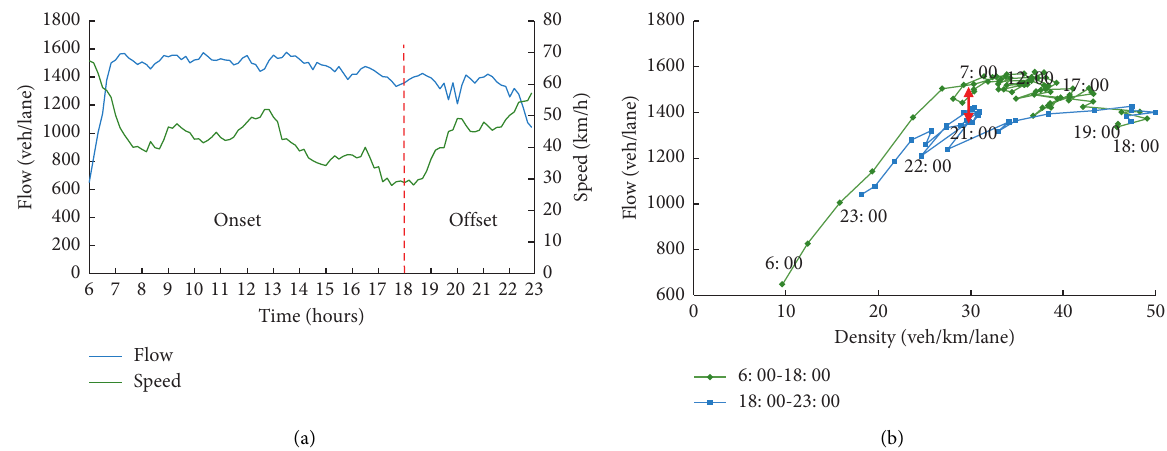
Figure 1: FCD speed and corresponding RTMS flows averaged over five days for the whole network. (a) Time-series of speed and flow. (b) Variation of flow with